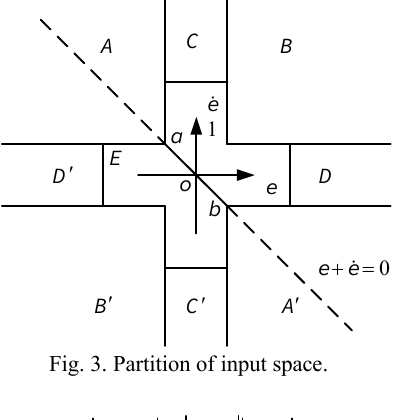
Fig. 3. Partition of input